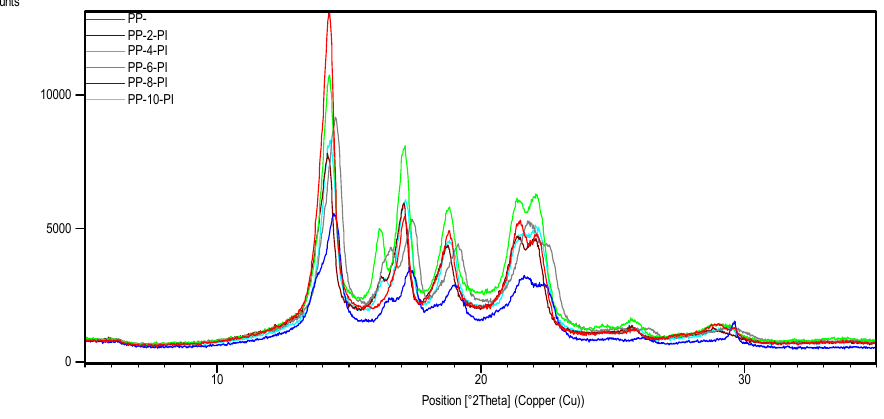
Figure 8. XRD pattern for PP and PP-PI composites.